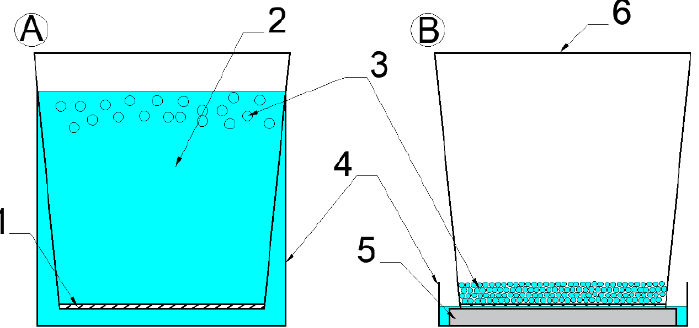
Figure 2. Scheme of the absorption experiment ( A ) conventional experiment; ( B ) modified experiment for Creasorb: 1. filtration cloth, 2. absorbed liquid, 3. swelling SAP, 4. vessel with solution, 5. sponge, and 6. vessel with filtration cloth (VFC).